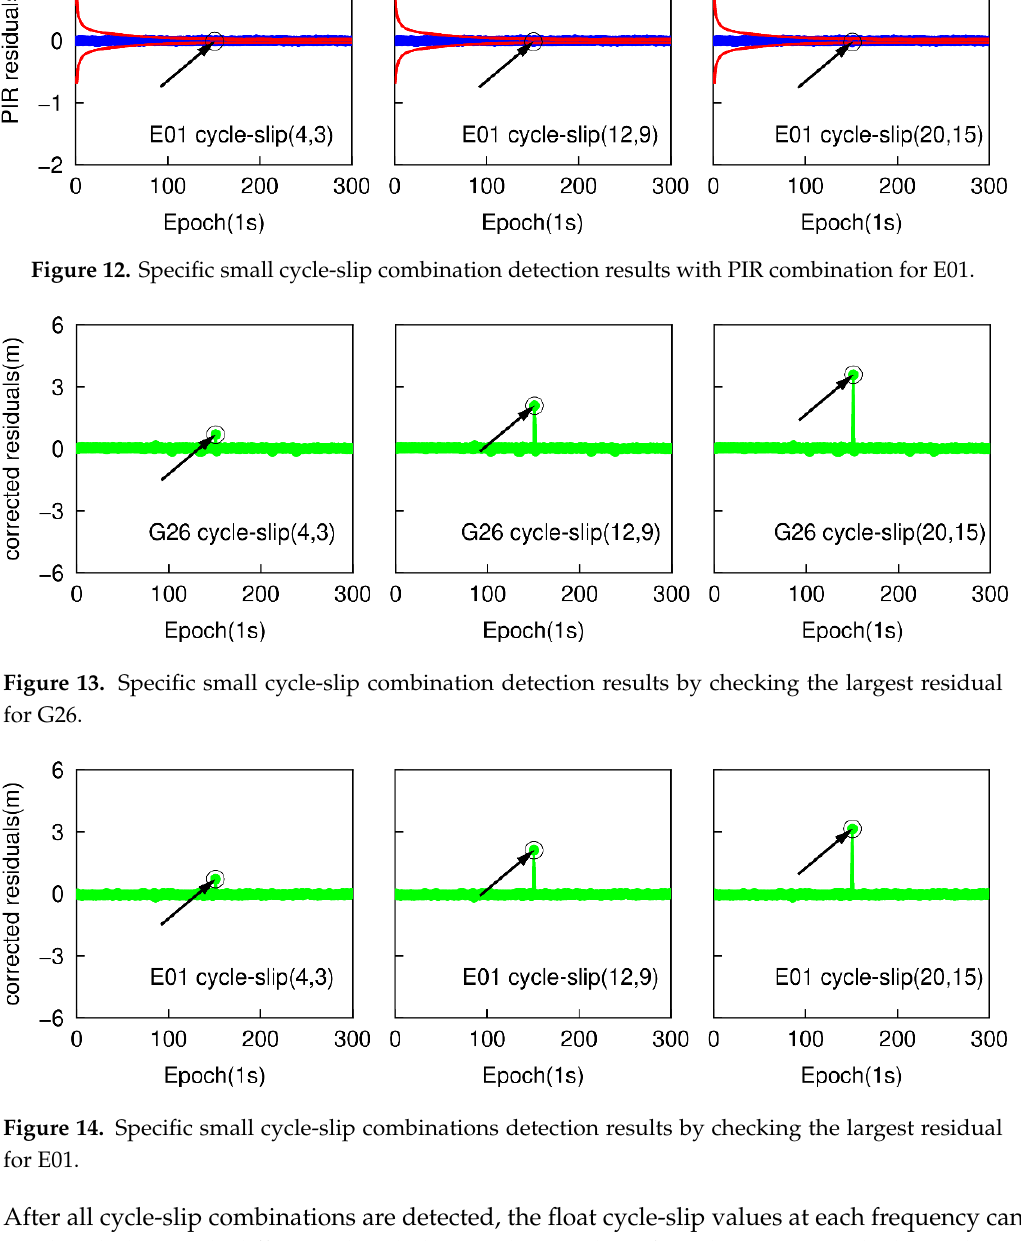
Figure 12. Specific small cycle-slip combination detection results with PIR combination for E01.